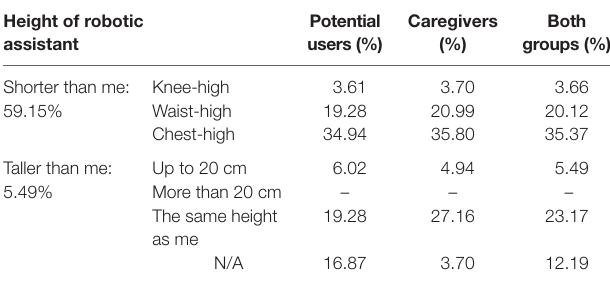
Table 6 | Percentage distribution of respondents’ preferences regarding to height of the robot. height of robotic assistant Shorter than me: